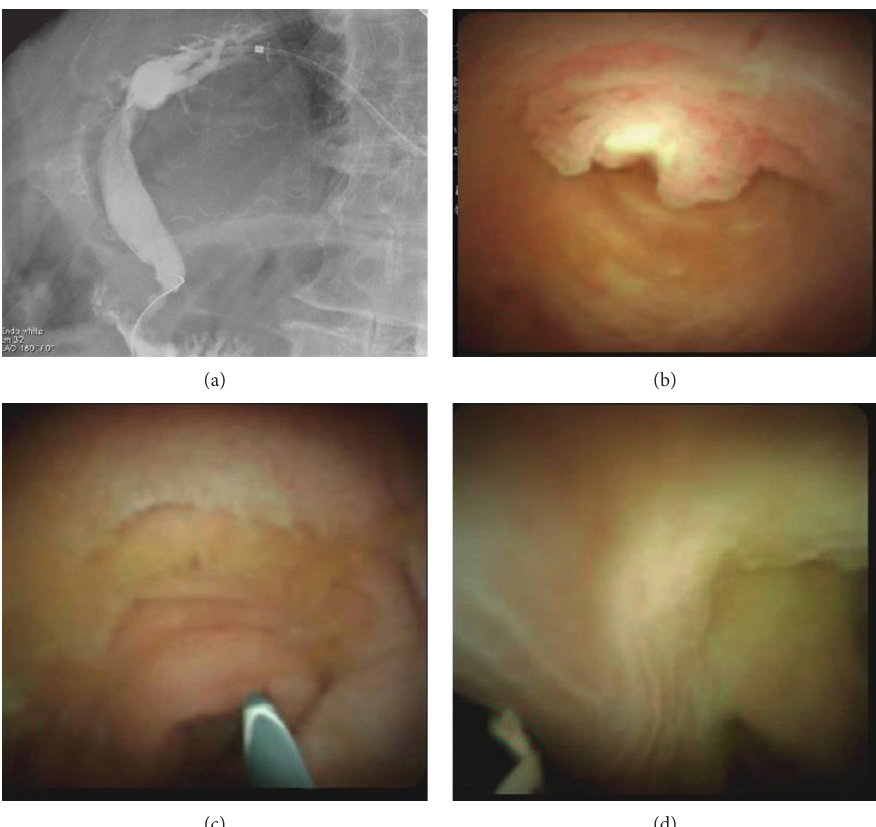
Figure 8: (a) Cholangiogram showing complete clearance of stones from the common bile duct. (b–d) Cholangioscopy showing normal distal common bile duct and ampulla with no residual stone